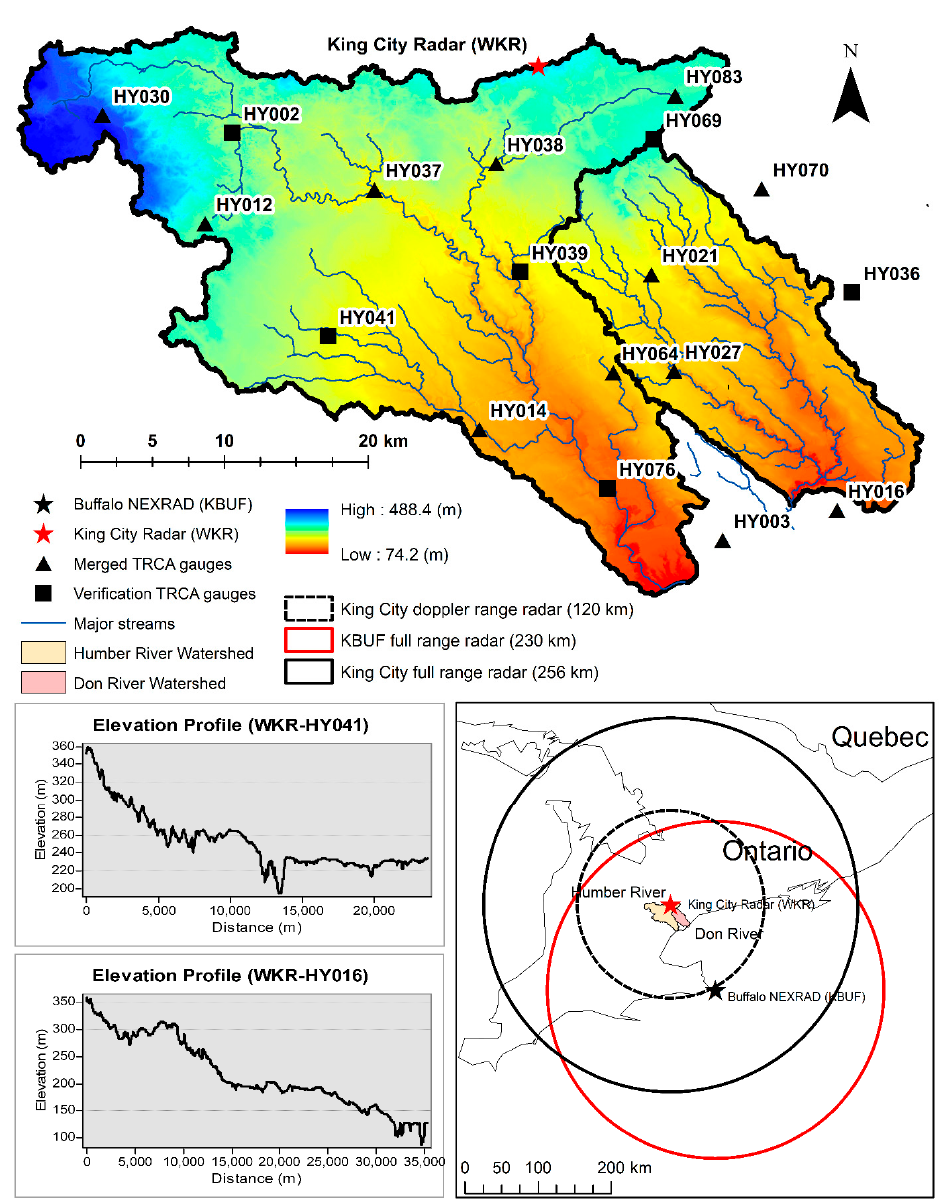
Figure 1. Humber River and Don River watersheds, and coverages of the nearest radar sites (WKR and KBUF).